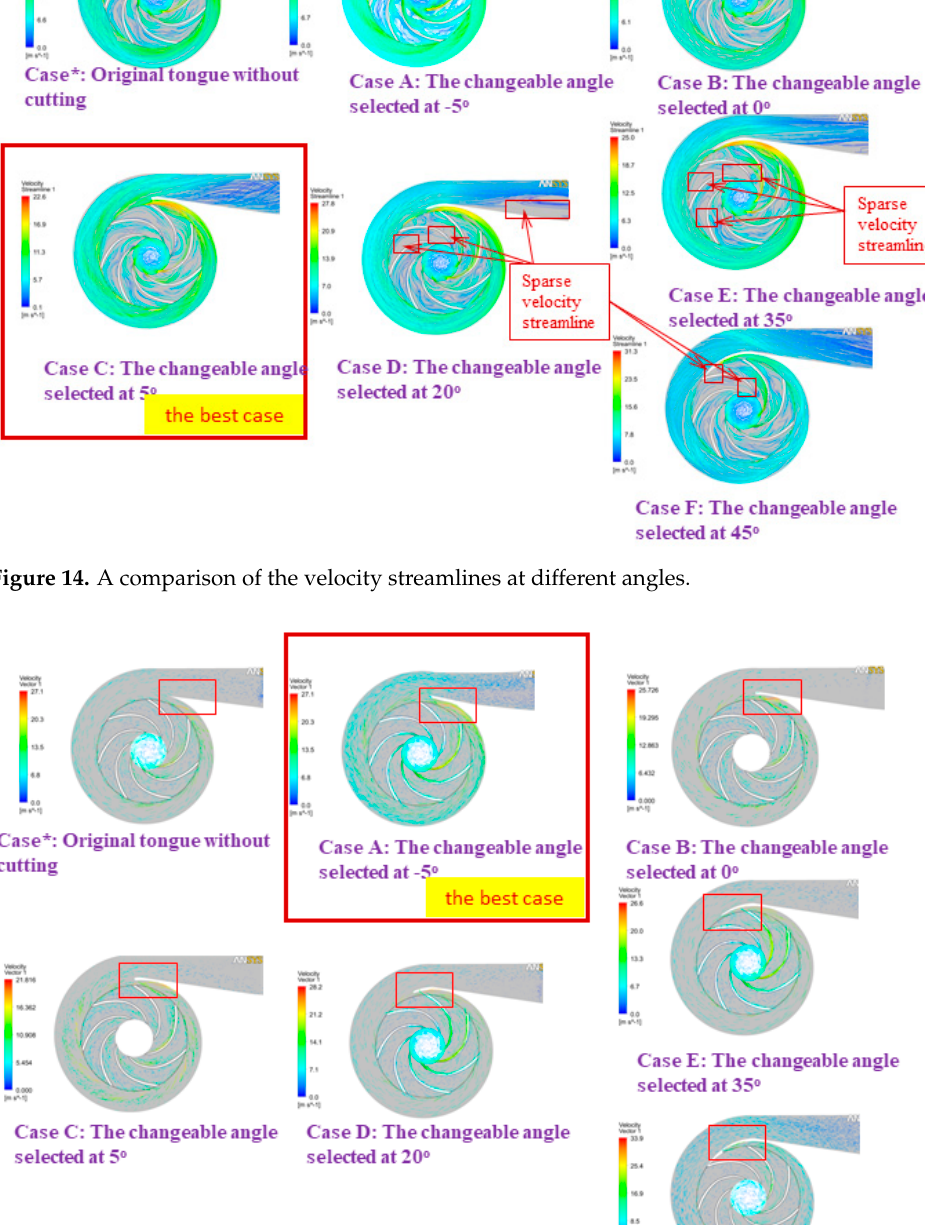
Figure 15. Velocity vectors of various angles in comparison.